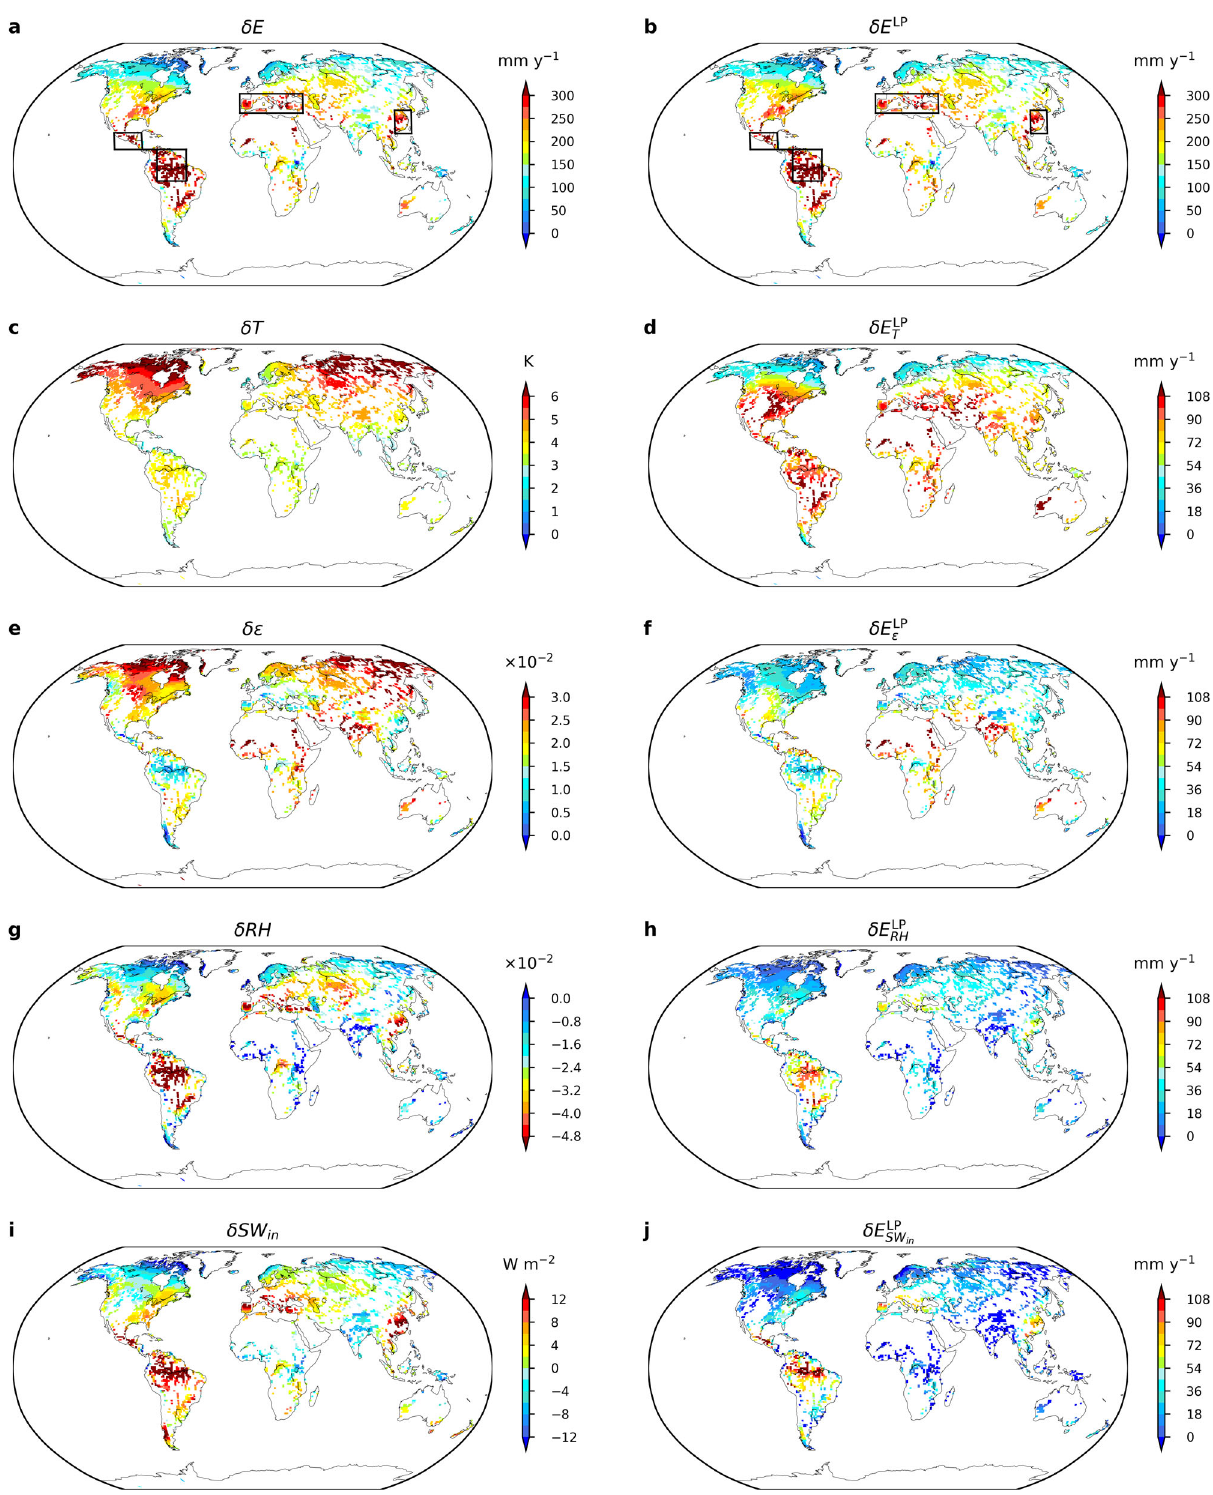
Fig. 2 Understanding the spatially varying lake evaporation increase based on the longwave-untangled Penman (LP) equation. a Spatial pattern of the lake evaporation increase projected by CLM ( δ E ). b Spatial pattern of the lake evaporation increase estimated by the LP equation ( δ E LP ). c , e , g , i Changes in the annual-mean air temperature ( δ T ), emissivity ( δ ϵ ), relative humidity ( δ RH ) and incoming shortwave radiation ( δ SW in ). d , f , h , j Contributions of individual factors to the lake evaporation changes according to the LP equation.